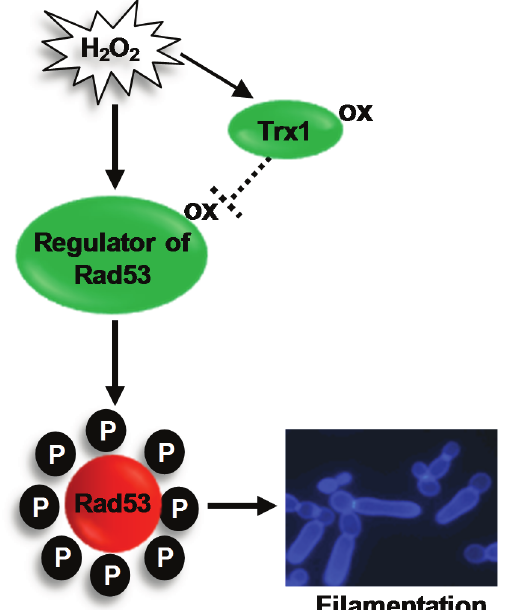
Figure 3. H 2 O 2 -induced activation of Rad53 triggers filamentation in C. albicans . The